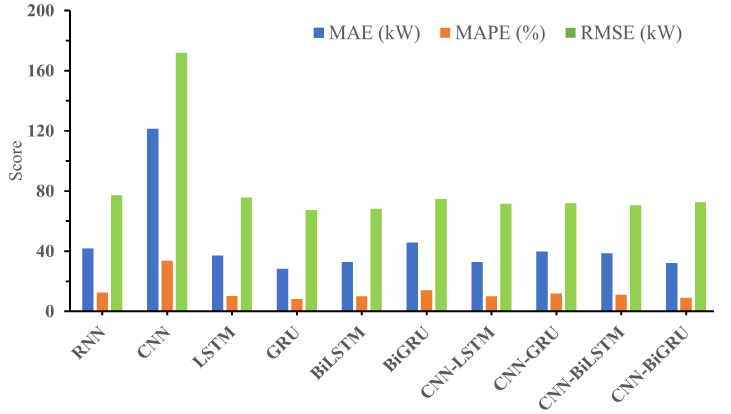
Figure 7. One-day PV generation forecasting on a regular weather day obtained by the hybrid model and compared with actual PV generation data. The inset figure shows the forecasting performance of the hybrid model between 12 and 16 h. In the hybrid deep learning model, the most preferable model for short-term prediction of the PV power generation on a regular weather day is CNN-BiGRU model.